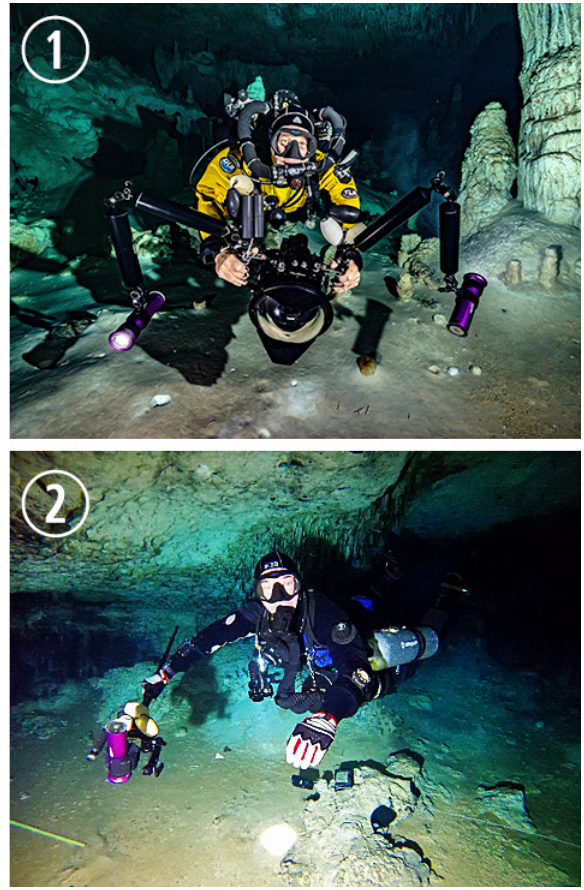
Figure 7 . Comparative pictures of: (1) high-performance, large- volume DLSR photogrammetry setup ; (2) compact,